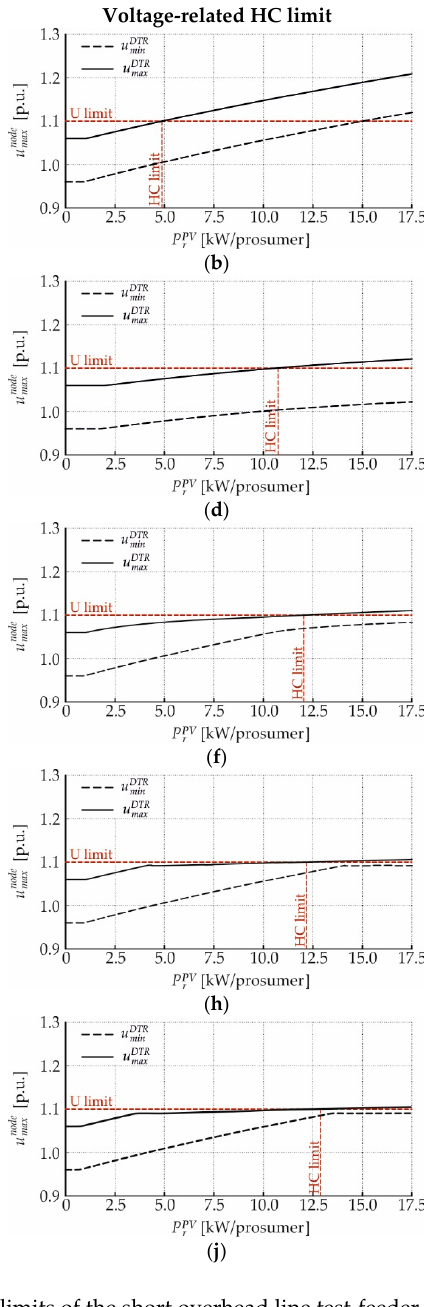
Figure 9. Current- and voltage-related hosting capacity limits of the short overhead line test-feeder for di ff erent control strategies: ( a , b ) no-control; ( c , d ) cos ϕ ( P )-control; ( e , f ) Q ( U )-control; ( g , h ) L ( U )-control; ( i , j ) L ( U )-control and Q -Autarkic